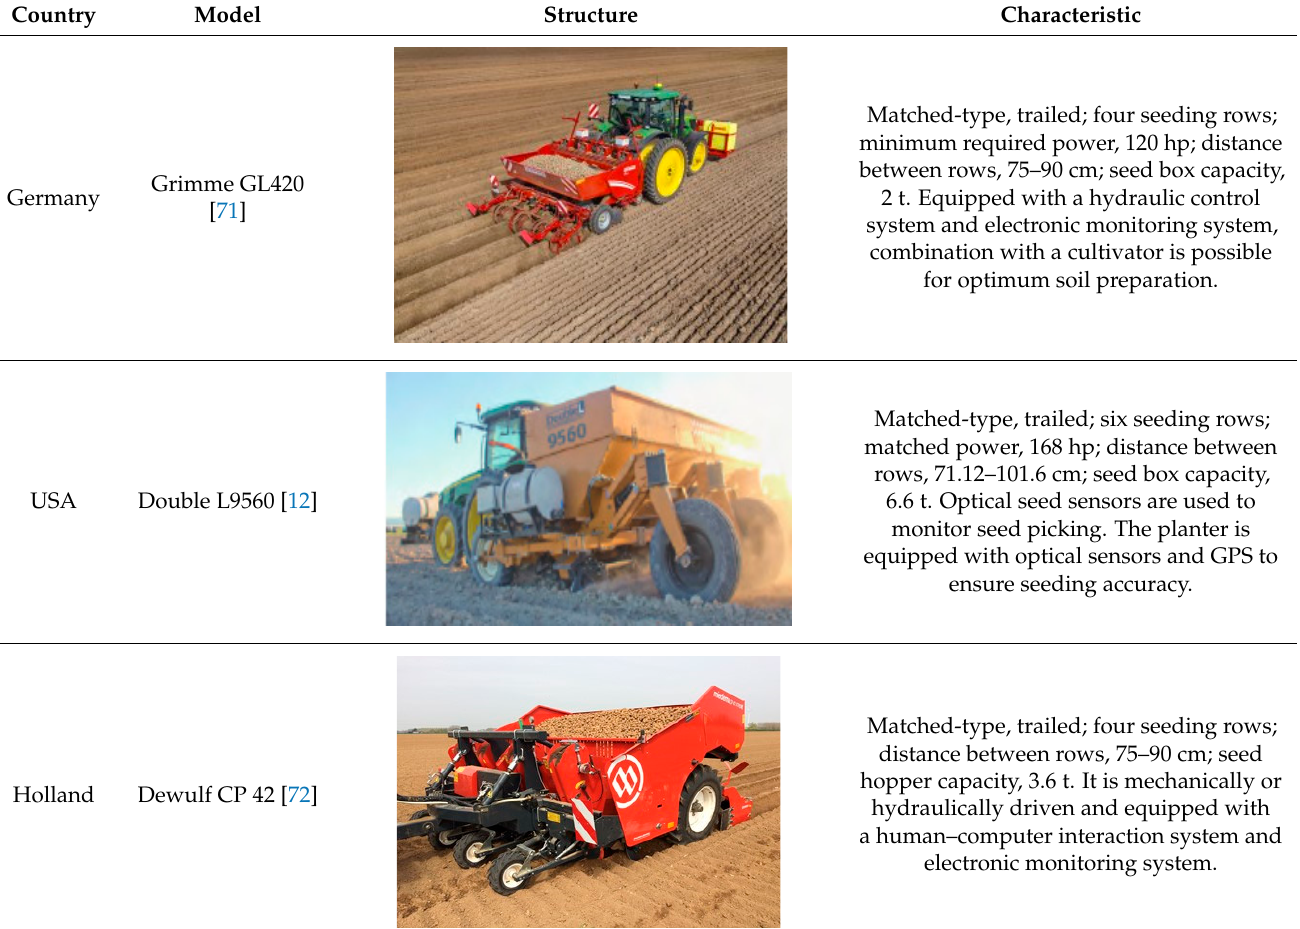
Table 5. Introduction of Cup-belt (chain) type planters.